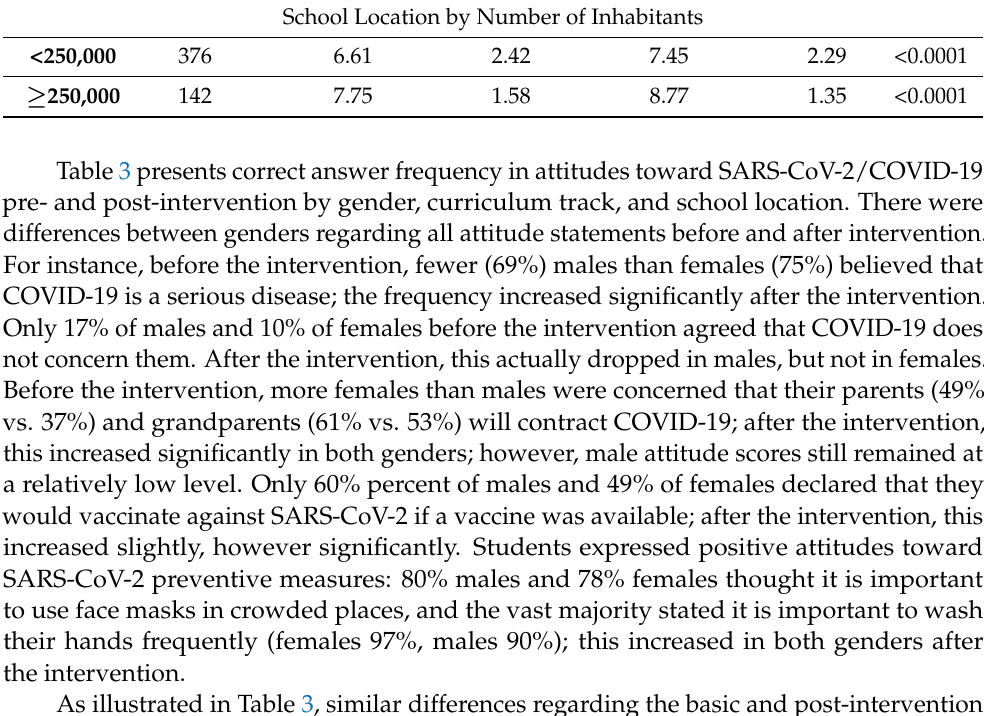
Table 2. Attitudes toward SARS-CoV-2 and COVID-19 pre- and post-intervention by gender, division, and school location; final year high school students, Poland, 2020 ( n = 518). Variable n Pre-Intervention SD Post-Intervention SD p Total 518 6.92 2.28 7.81 2.15 <0.0001 Gender Males 176 6.84 2.39 7.66 2.32 <0.0001 Females 342 Division Life 376 science Other 142 School Location by Number of